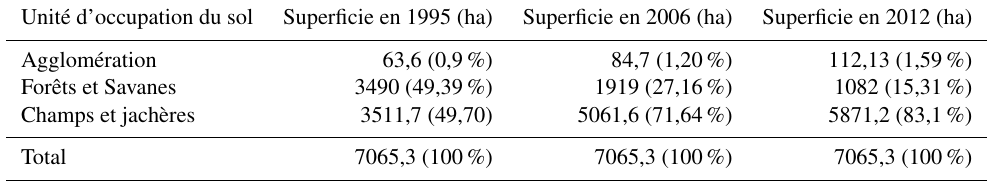
Tableau B1. Evolution des unités d’occupation du bassin versant selon les degrés d’anthropisation.